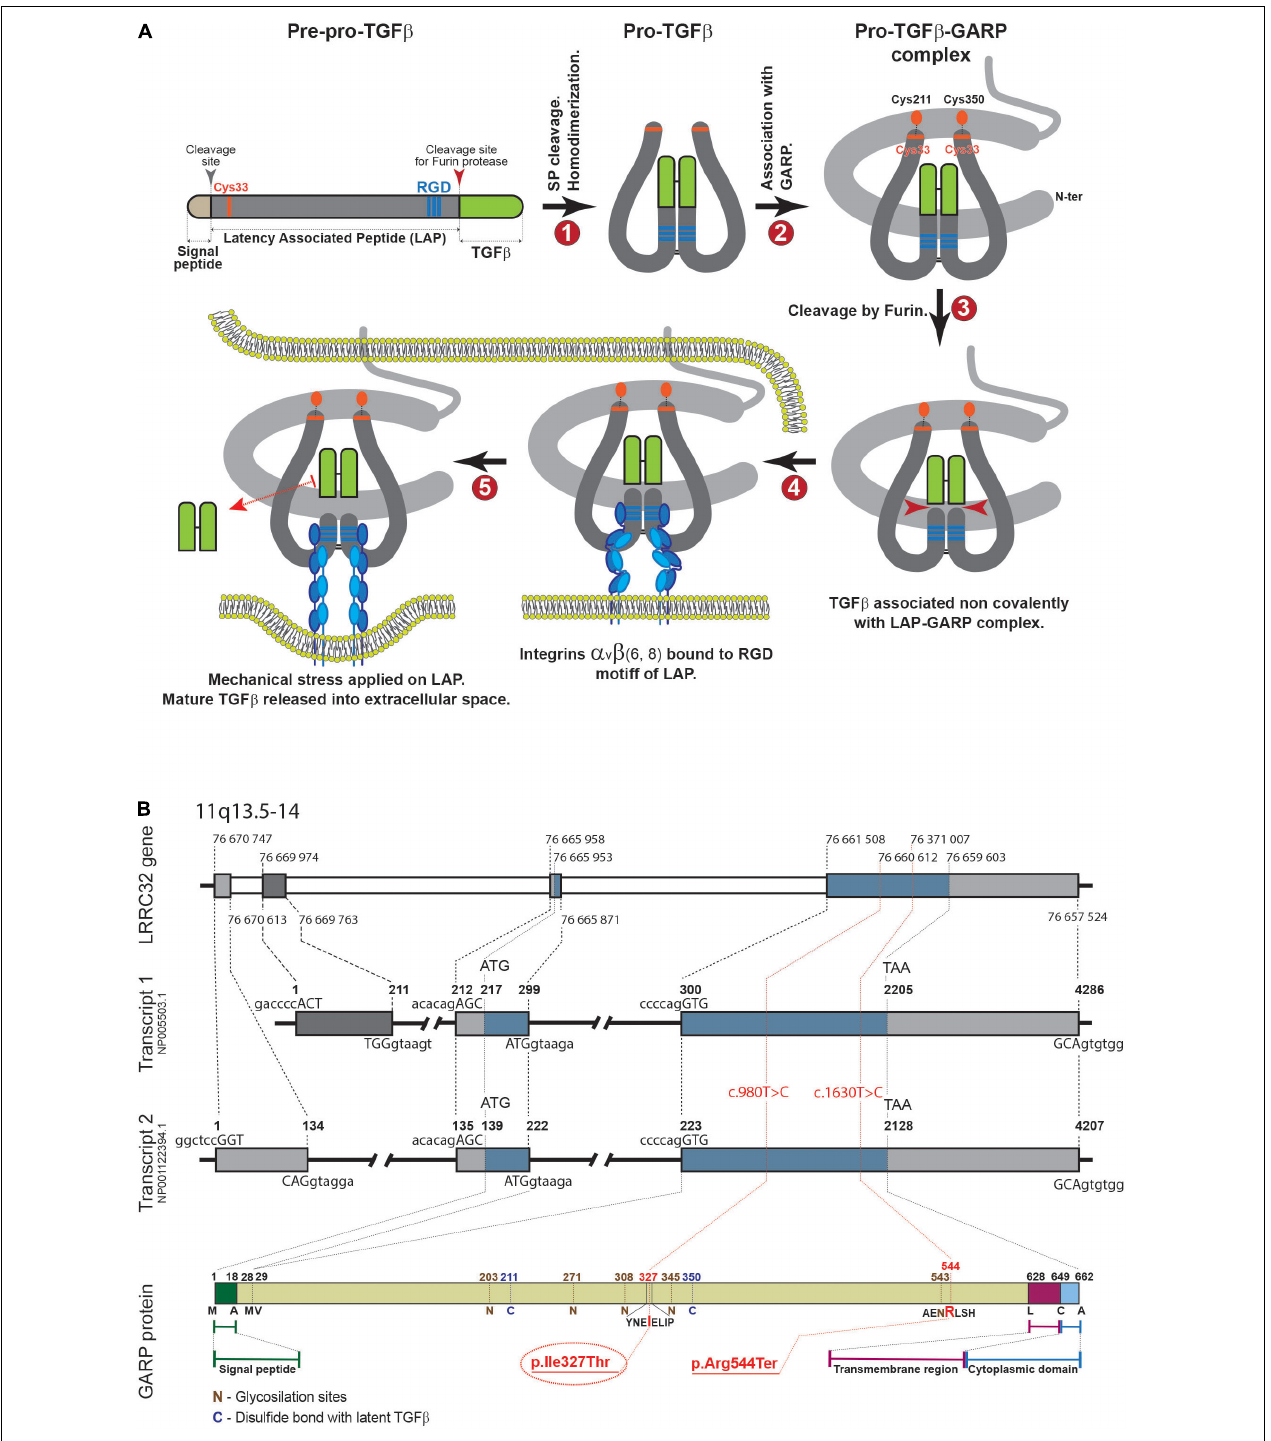
FIGURE 4 | (A) Maturation process of TGF- β . (B) Upper panel. Genomic structure of LRRC32 . Introns and exons are represented as gray and blue boxes, respectively. The start of each intron and exon is marked with dashed lines (nucleotide numbers are shown). Middle panel (transcripts 1, 2). Two major transcript types are shown. The numbers above each transcript delineate the beginning of each exon and intron, and the first nucleotides of start or stop codons. Sequences of 5 (cid:48) - and 3 (cid:48) -boundaries of exons are shown above and beneath each transcript, respectively (capital letters correspond to exons). In the lower panel, the protein product is shown with some key amino acids. The reported new variant is indicated in